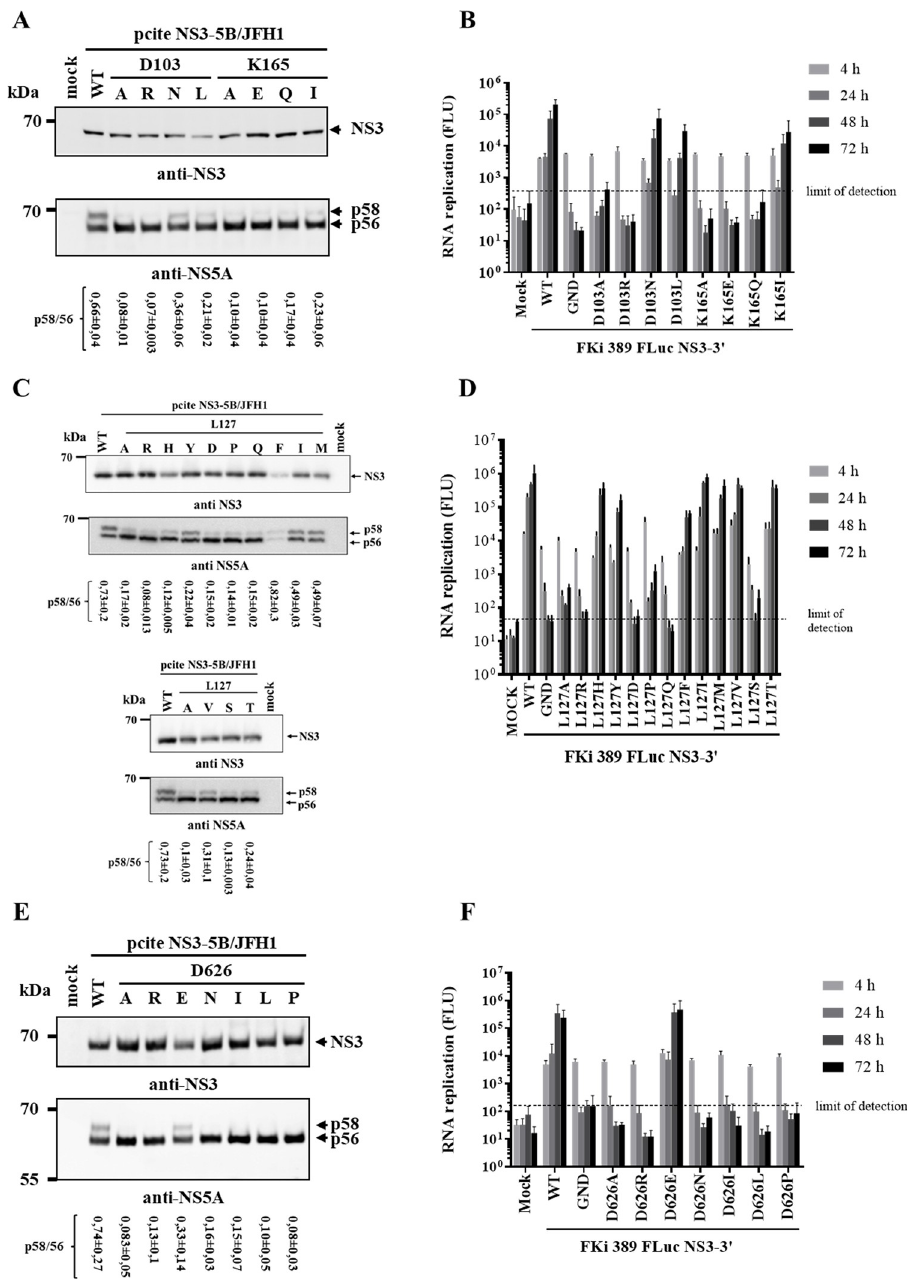
Fig 4. Characterization of amino acid requirements at critical NS3 surface positions by limited permutation analysis of D103, L127, K165 and D626. NS3 permutations mutations were introduced into pcite NS3-5B/JFH1 to analyze effects of the NS3 permutations on NS5A hyperphosphorylation in the MVA-T7- pol expression system in Huh7-T7 cells. NS3 permutations in pFKi 389 FLuc NS3-3’/JFH1 were applied to determine their impact on viral RNA replication in Huh7 Lunet cells. (A, C and E) Analysis of HCV polyprotein processing and NS5A hyperphosphorylation by anti-NS3 and NS5A-specific Western blot. Western blots shown are representative for three independent experiments. Quantification of the p58/p56 ratios based on the Western blots are shown below the respective WB panels. The quantifications were performed with ImageJ and are from three experiments (n = 3). The p58/p56 signals were normalized to the respective NS3 signal. (B, D and F) RNA replication analysis of D103, K165 and D626 permutations. RNA replication capacities of mutated replicon RNAs in Huh7 Lunet cells was measured by determining firefly luciferase activities (FLU) at 4, 24, 48 and 72 h pe. Mean values of three independent experiments are shown. Error bars indicate standard deviations. The background of the replication assay is indicated by the horizontal dashed line. WT: wild type, GND: NS5B replication-deficient